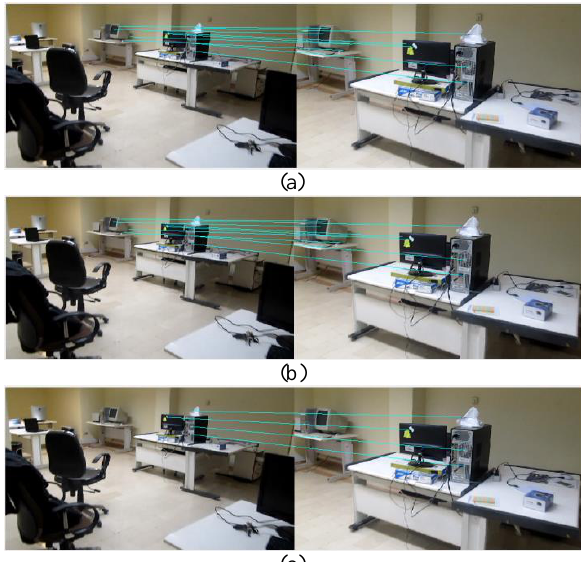
Figure 4. a. Extracted matched points, b. Non-obstacle points are removed and the remaining obstacle candidate points,